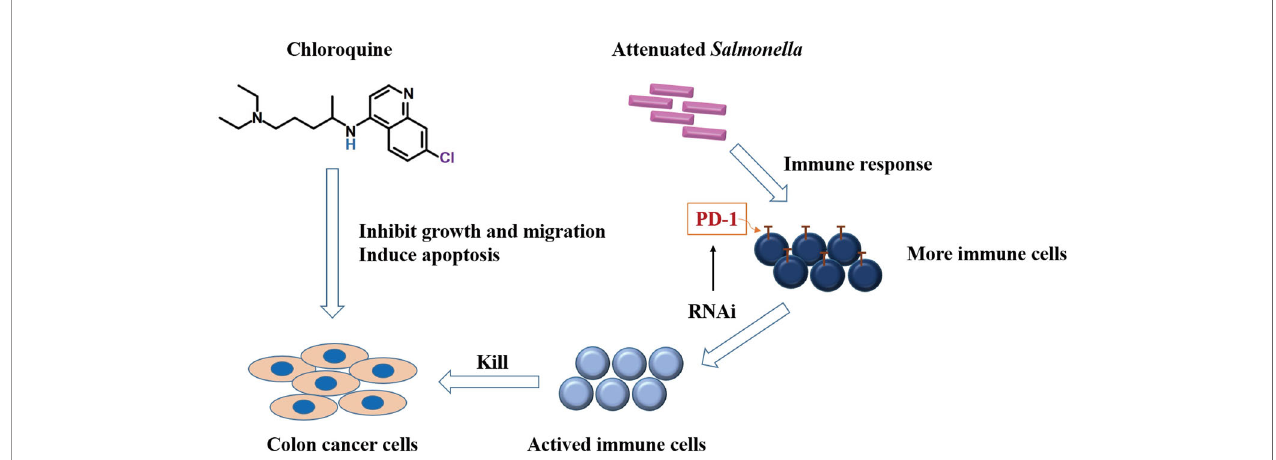
FIGURE 8 | Schematic diagram demonstrating the potential mechanism of chloroquine and PD-1 siRNA in